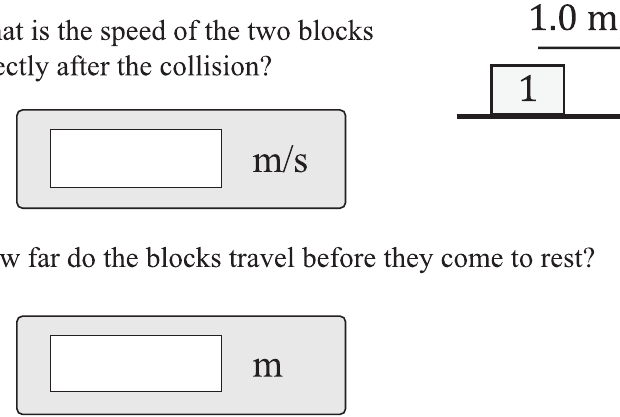
FIG. 10. Example of a failed subskill that attempts to target multiple skills